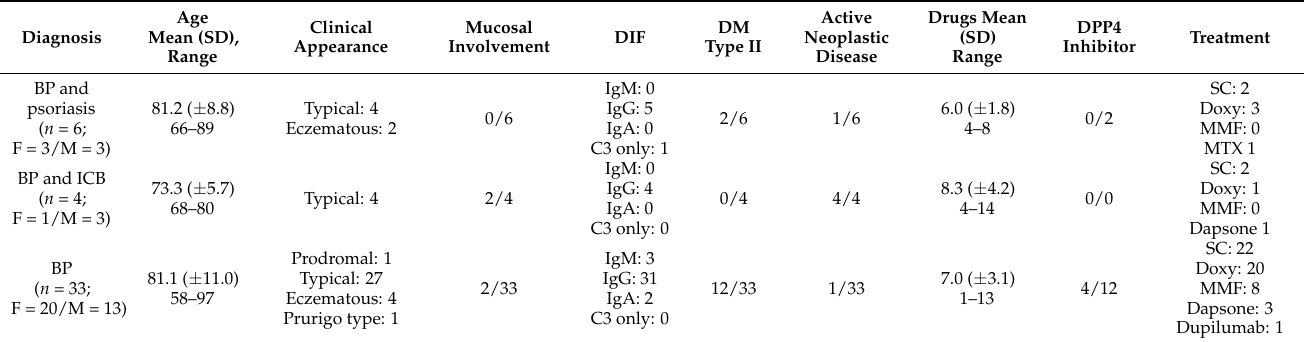
Table 1. Patient characteristics. Patients with BP receiving ICB were younger and had a higher daily intake of prescribed drugs; diabetes mellitus type II was less common.